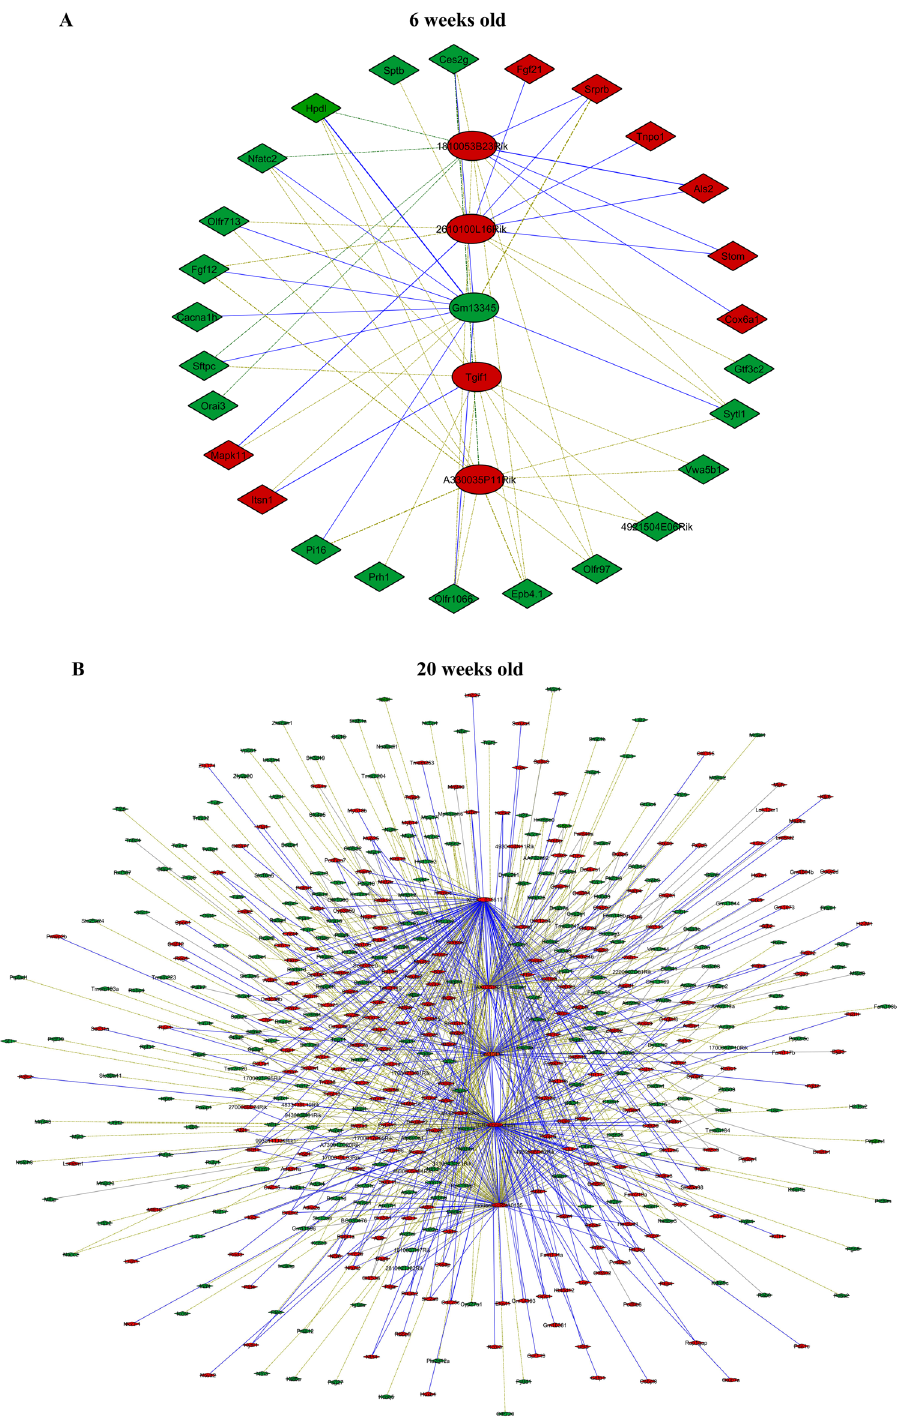
Figure 4. Connections of five deregulated circulating lncRNAs with mRNA transcripts in db/db mice with and without diabetic cardiomyopathy. (A) The network of lncRNA-mRNA co-expression in 6-week-old db/db mice; (B) the network of lncRNA-mRNA co-expression in 20-week-old db/db mice. The network represents the co-expression correlations between the significantly differentially expressed lncRNAs and mRNA transcripts. Five lncRNAs having maximum connections with differentially expressed genes were taken to construct the co-expression network (Pearson correlation > 0.995 or < − 0.995 and P < 0.05). Circles, squares, and V shapes indicate lncRNA transcripts, transcription factors, and mRNA transcripts, respectively. Solid arrows and dashed lines indicate positive and negative correlation, respectively, whereas red and green colors represent up- and down-regulated transcripts. The width of the line is based on Person’s value (stronger correlation corresponds to more width) and color of the line depicts the significance. Nodes indicate lncRNAs or